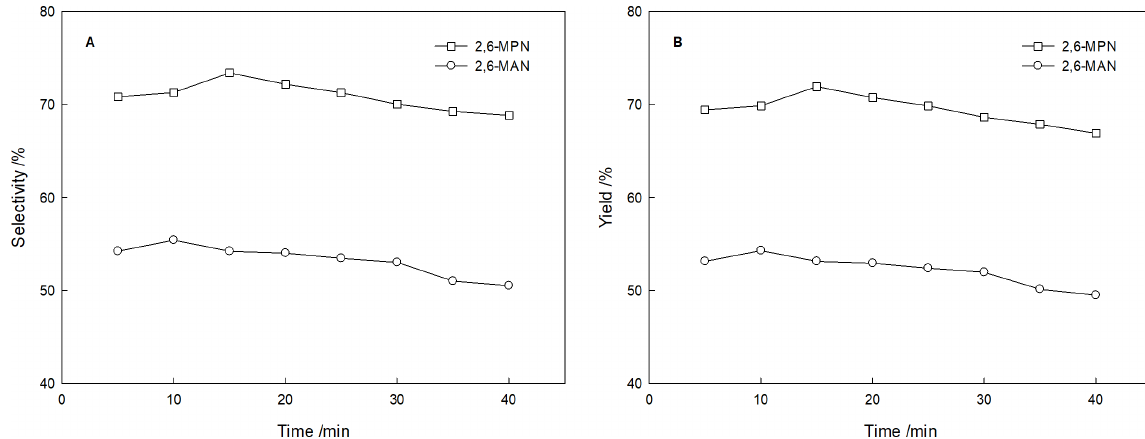
Figure 4: The relationship between the reaction time and the results of the acylation reaction of 2-MN. (2-MN:AlCl :PC or AC = 0.15:0.17:1, AlCl 3